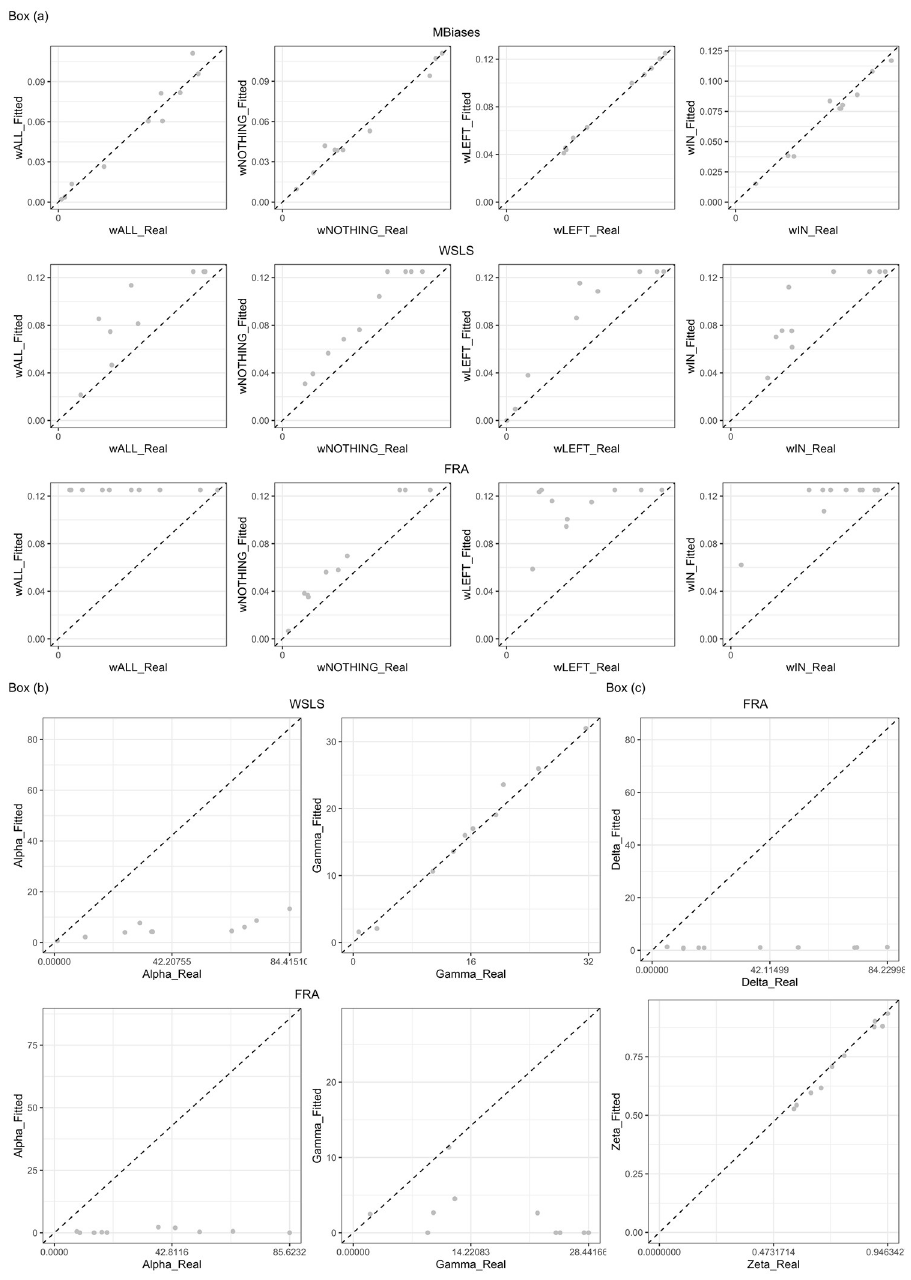
Fig 8. Model recovery exercise. All panels plot the value of the parameter that was input to the simulation ( x -axis) against the parameter recovered by the maximum likelihood method ( y -axis). Each data point corresponds to one simulation with a given set of randomly chosen parameters. In a perfect world, all points should fall in the y = x line. Box (a) shows the results for the first four parameters, corresponding to the biases. Box (b) corresponds to parameters controlling “Win Stay, Lose Shift.” Box (c) corresponds to parameters controlling